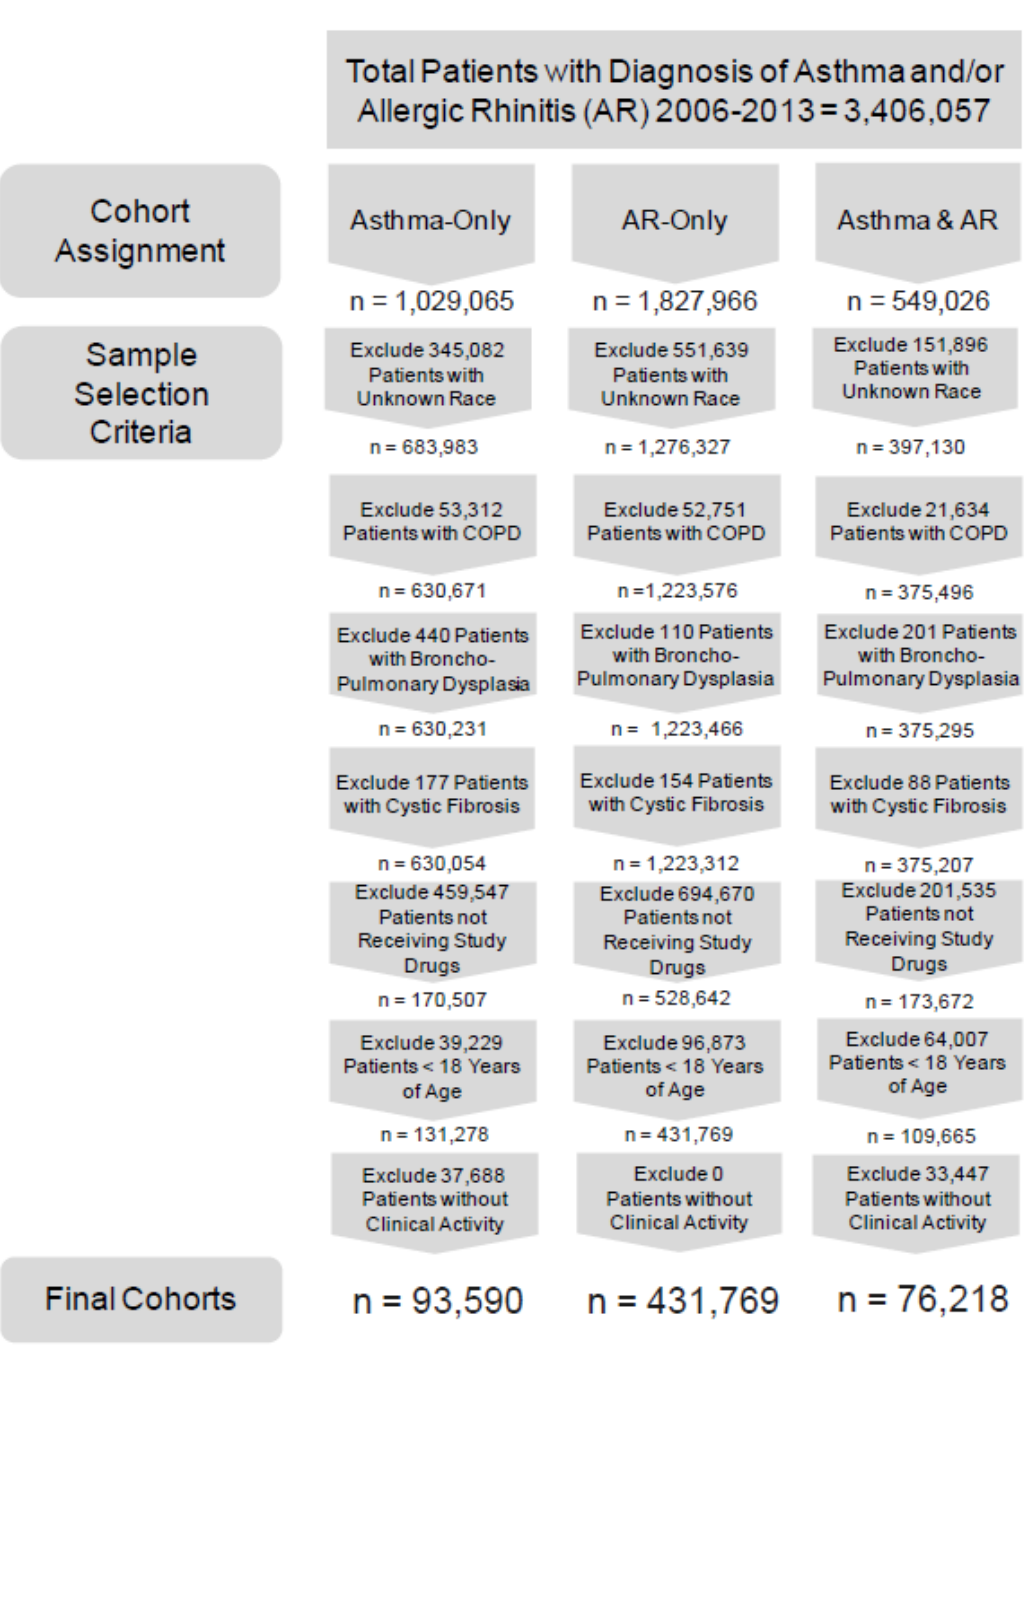
Figure 2. Attrition of Patients during the Sample Selection